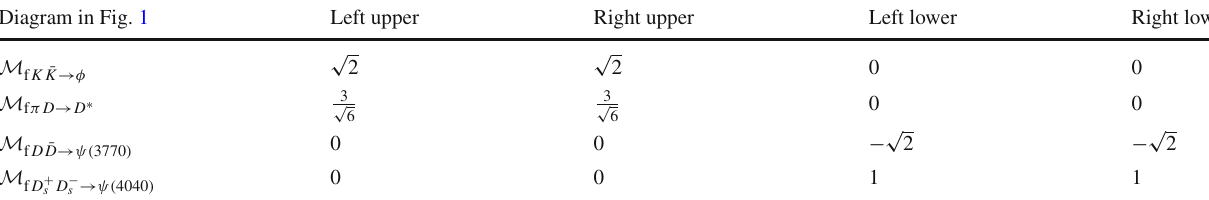
Table 1 Flavor matrix